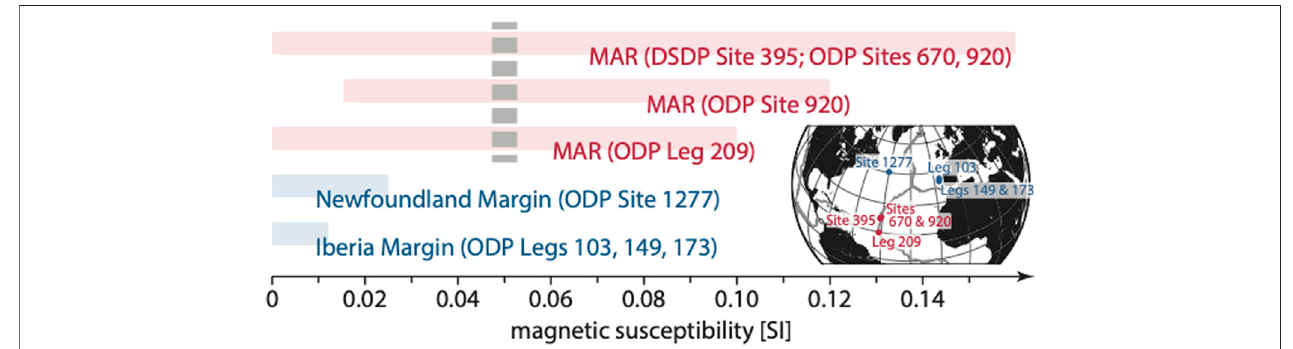
FIGURE11| Magneticsusceptibilitiesofdrilledserpentinites.Atmagma-poormargins,magneticsusceptibilitiesofextensivelyserpentinizedrocksarelow;thosein rocks from theMARaregenerallymuch higher.Since magnetite formation increases withtemperature,thehighmagnetic susceptibilities oftheMAR rocks areindicative ofserpentinizationthattookplaceinexcessof200 ° C.MARsampleswithmagneticsusceptibilities < 0.05SI(dashedgraybar)likelyrelatetosampleswithlowdegreesof alteration (the amount of magnetite correlates with the degree of serpentinization; see Ou fi et al., 2002) or may mirror late-stage serpentinization at lower temperatures (e.g., Bonnemains et al., 2016) or alteration of magnetite to maghemite (Ou fi et al., 2002). This fi gure includes data from Boillot et al. (1987), Sawyer et al. (1994),Whitmarshetal.(1998),Ou fi etal.(2002),Kelemenetal.(2004),Tucholkeetal.(2004),Kleinetal.(2014),Bonnemainsetal.(2016).Weonlyconsideredultrama fi c cores with no/little fault gouge from ODP Leg 209, i.e., Cores 2R – 11R, 18R, 19R, 24R of Hole 1268A; 1R, 2R, 4R of Hole 1270A; 1R – 3M of Hole 1270C; 11R of Hole 1270D; 6R of Hole 1271A; 2R, 7R, 18R of Hole 1271B; 12R, 14R, 16R – 21R, 23R – 27R of Hole 1272A; 1R – 17R, 27R of Hole 1274A.